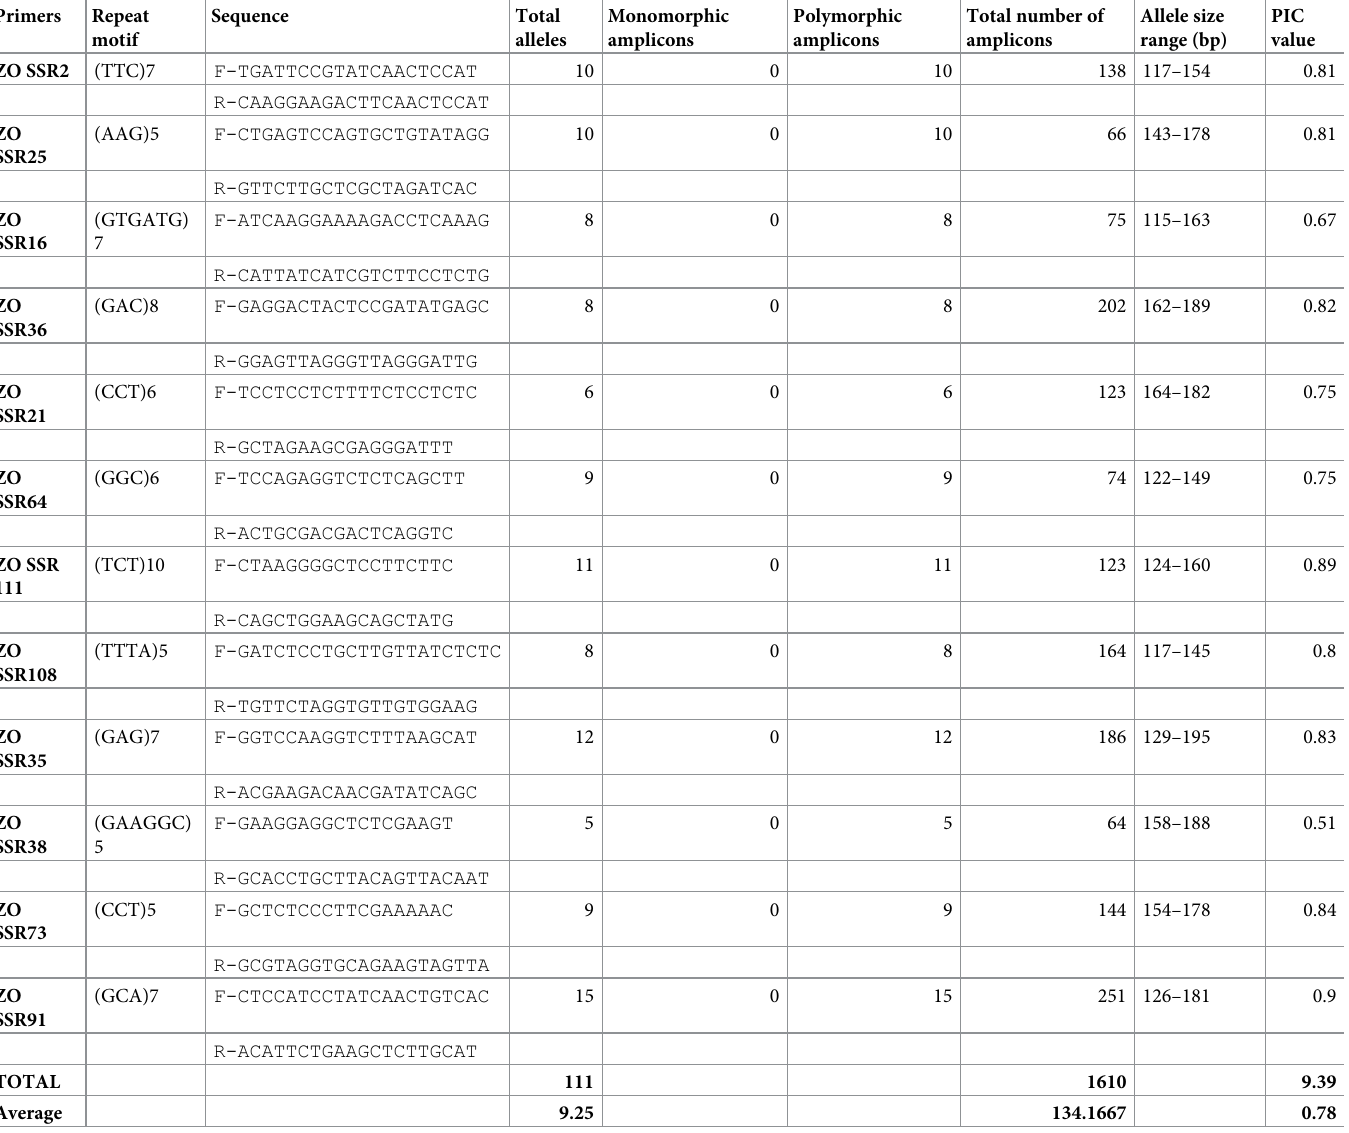
Table 3. Characteristics of 12 selected primers designed for analysing genetic diversity of ginger and PIC